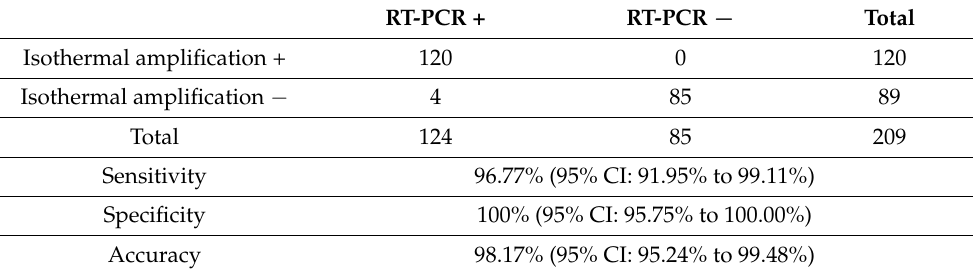
Table 1. Comparison between isothermal amplification/saliva and RT-PCR/NPS detection of SARS- CoV-2 on 209 supervised samplings giving interpretable NEAR results.